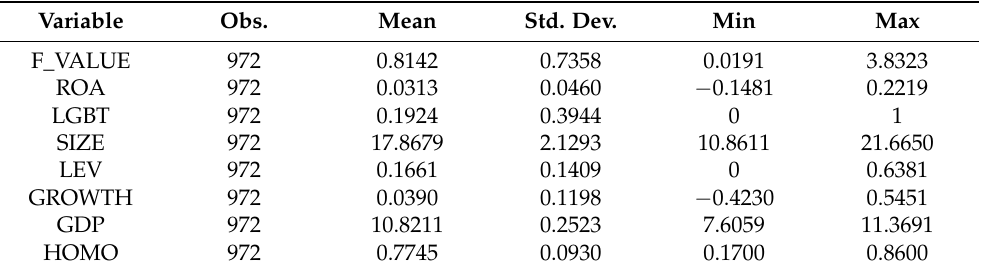
Table 3. Descriptive statistics of variables.